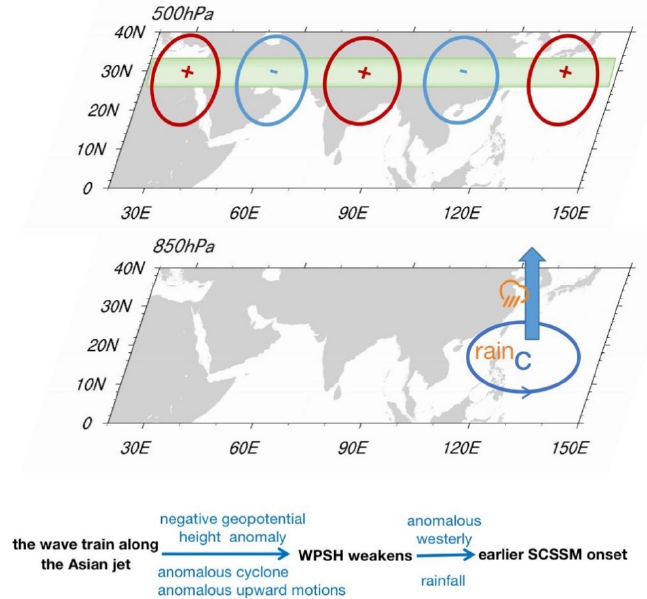
Figure 8. A schematic diagram of the mechanism of the SCSSM onset affected by the wave train along the Asian jet. The “+” and “ − ” symbols denote southerly anomalies and northerly anomalies at 500 hPa, respectively. The light green shaded belt represents the climatological Asian jet at 500 hPa in May. Letter “C” represents an anomalous cyclone over the SCS and the Philippine Sea. A thick vertical arrow indicates anomalous ascending motions.